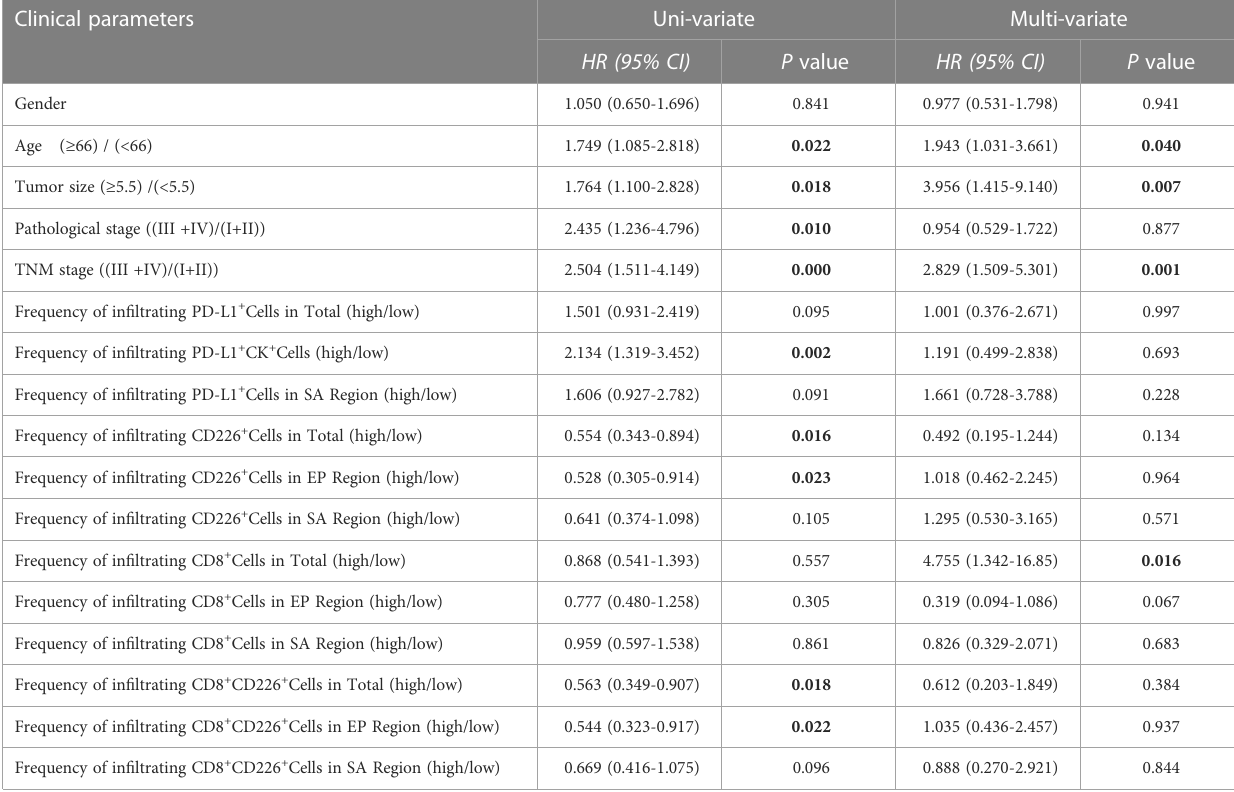
TABLE 6 Uni-variate and multi-variate analysis of clinical parameters of GC patients. Clinical parameters Uni-variate